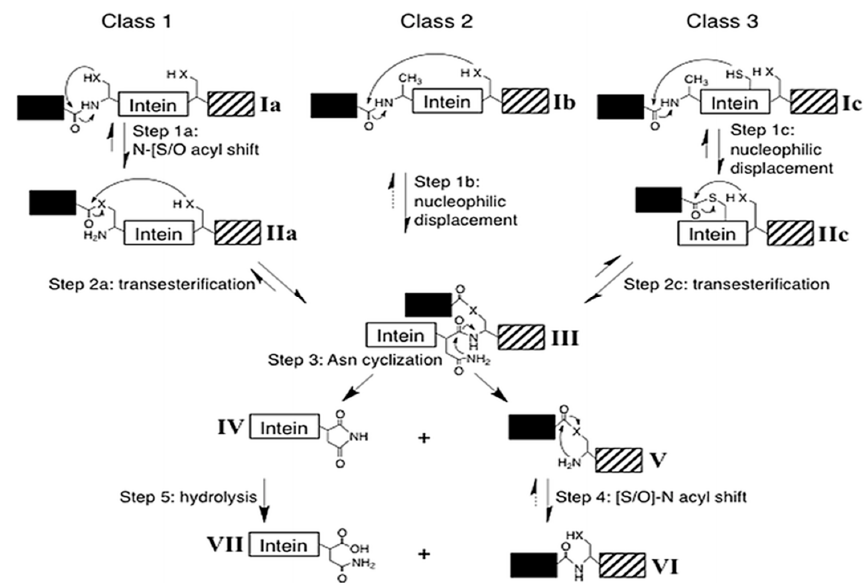
Figure 6. Intein-mediated protein splicing mechanisms in 3 classes of inteins. The majority of inteins follow the class 1 intein-mediated protein splicing mechanism, which consists of four coordinated nucleophilic displacements and requires Ser1, Thr1 or Cys1 as the intein N-terminal residue. Step 1a results in a linear (thio)ester intermediate and step 2a results in BIG with Cys+1, Ser+1 or Thr+1 as the branch point. Class 2 and 3 inteins do not require an intein N-terminal nucleophile. Class 2 inteins directly form BIG when the +1 residue attacks the N-terminal splice junction peptide bond. Class 3 inteins use a conserved Cys at Block F position 4 (CysF:4) to initiate protein splicing resulting in formation of the class-specific BIF. Once BIG is formed, the remaining reactions are the same for all inteins. The acyl shift in step 4 is rapid and spontaneous. Step 5 is also spontaneous but is often slow. Solid arrows represent steps that have been experimentally verified while dashed arrows represent theoretical steps. Note that steps 1 and 2 are reversible; the forward reactions are driven by kinetic rates, equilibrium positions toward the forward reaction, and substrate/intermediate elimination as the protein moves toward the final products, among other factors. Intein residues and flanking extein residues that assist these reactions are not shown, nor are tetrahedral intermediates. X represents the sulphur or oxygen atom in the side chain of Cys, Ser or Thr [104] .